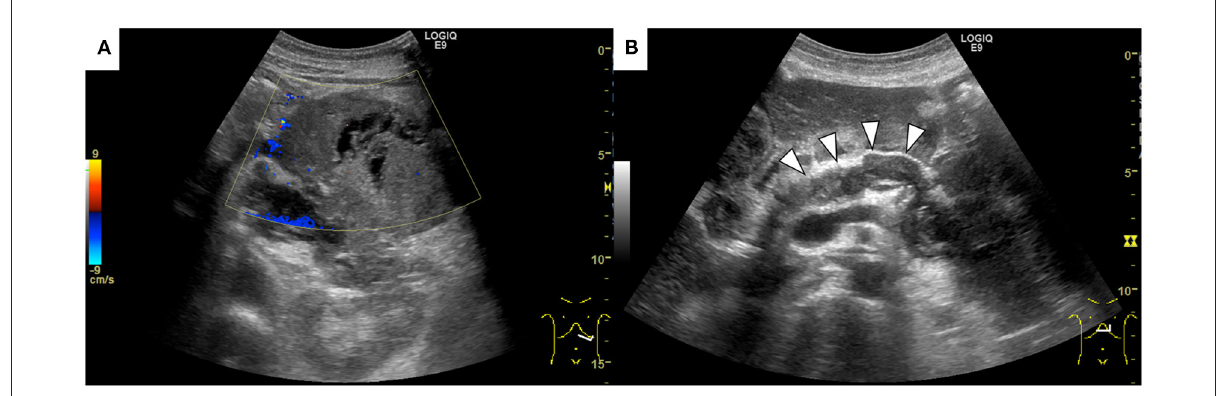
FIGURE1 Abdominal ultrasonography shows a well-defined, irregular-shaped, heterogeneous mass at the pancreatic tail (A) . The main pancreatic duct was dilated with hyperechoic structures inside (arrowheads) (B) .